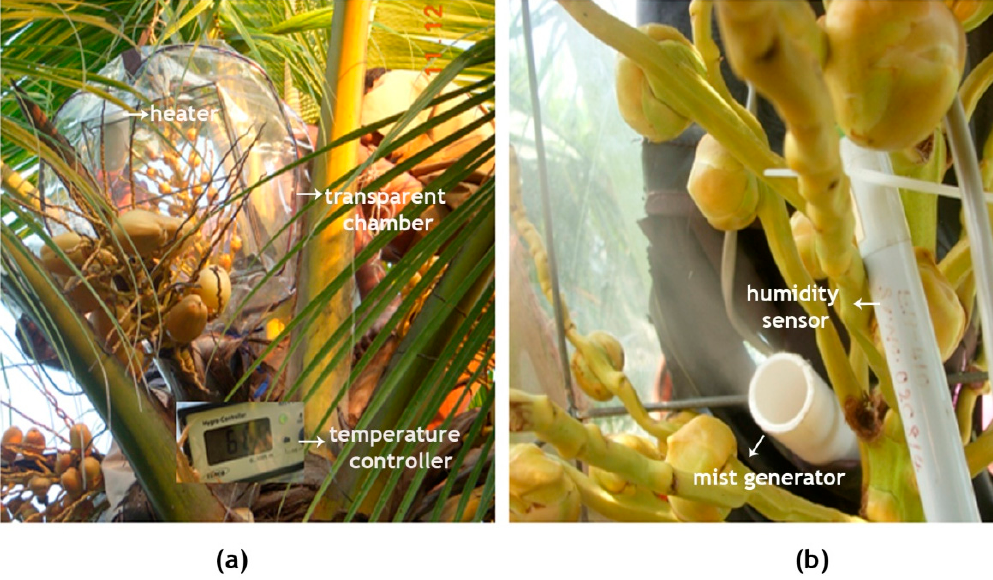
Figure 10. In vivo experimental setup for the induction of high temperature treatment of the inflorescence of the coconut variety WCT. ( a ) The inflorescence was enclosed in a transparent chamber fitted with a microprocessor ‐ controlled heater and ( b ) a mist generator for maintaining the temperature and humidity inside the chamber, respectively.